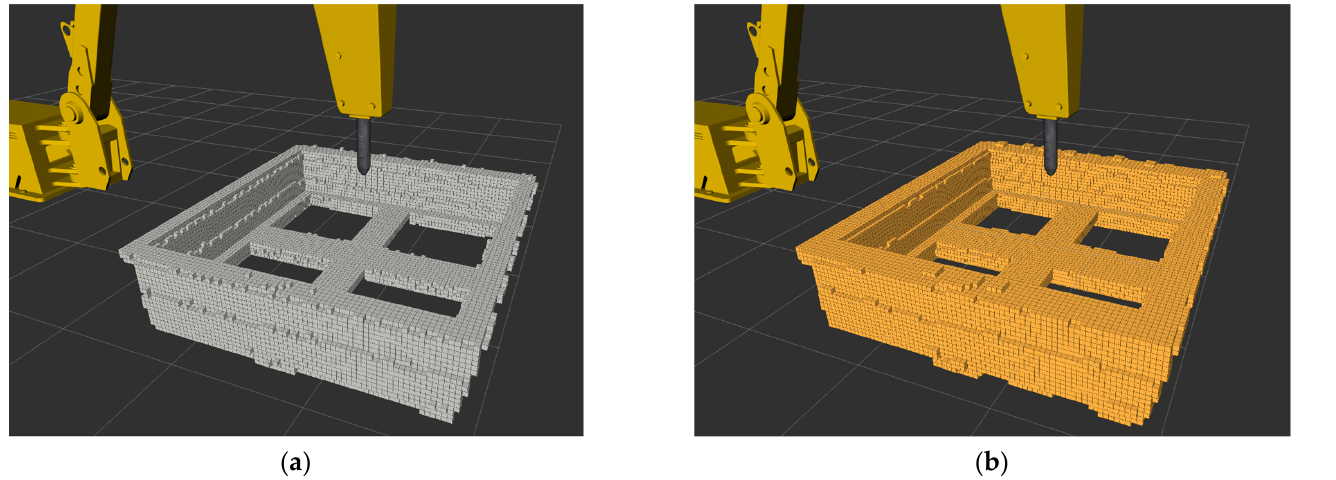
Figure 9. ( a ) The original collision cloud generated with the environment points. ( b ) The resulting collision point cloud after applying the dilation process.